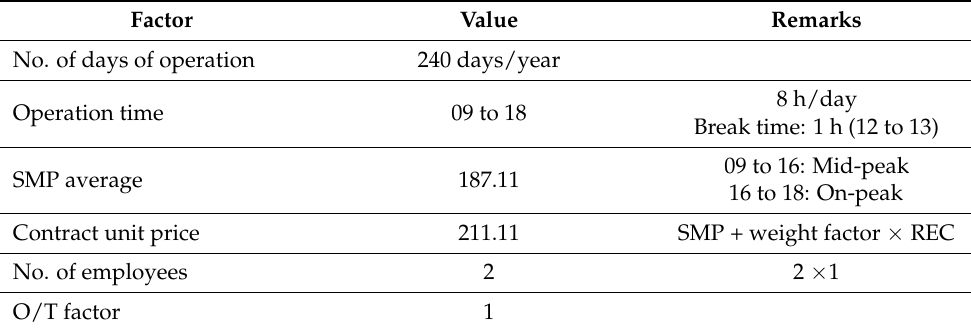
Table 20. Factors and their values are subject to the operation plan (Scenario